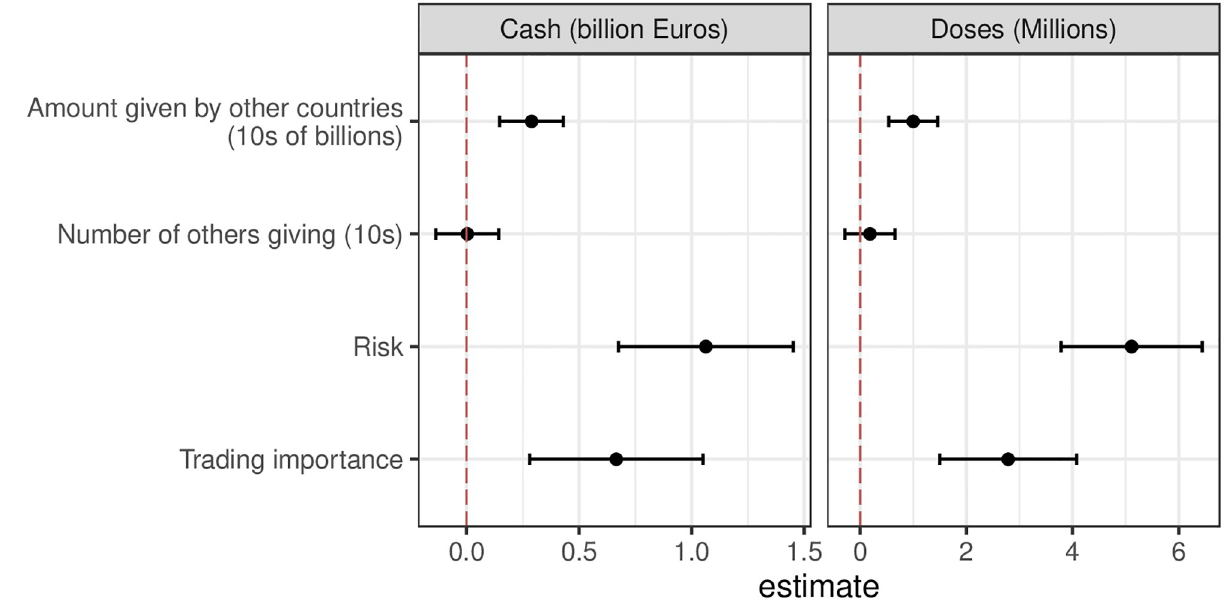
Fig 2. Marginal effects of